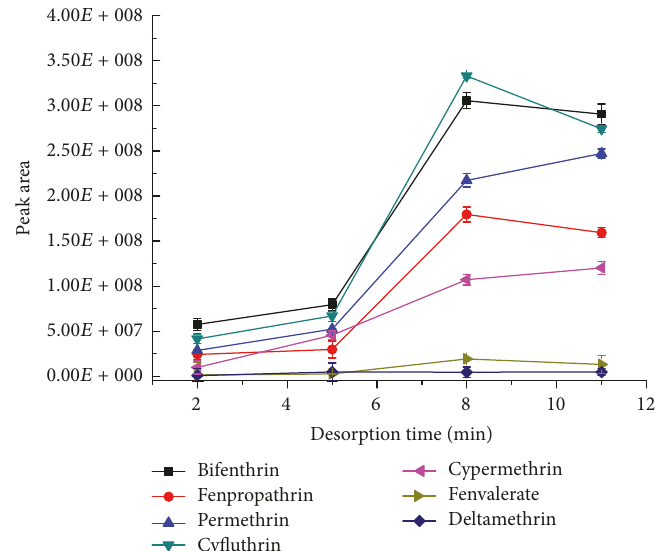
Figure 6: The effect of the desorption time on the desorption efficiency ( 𝑛 = 3 ). The standard mixture concentration: 20 ngmL −1 , stirring rate: 750 rpm, extraction time: 20 min, and desorption temperature: 280 ∘ C.